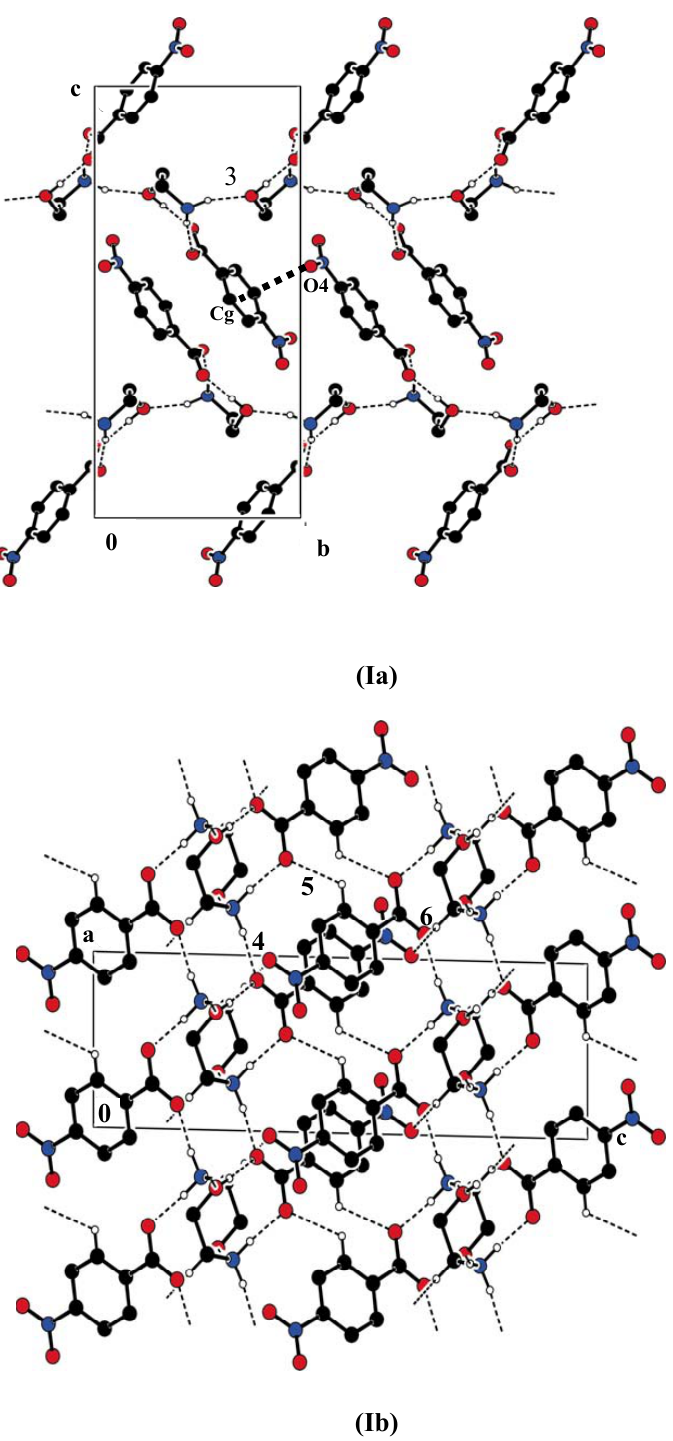
Fig. 2 ( Ia ) The helix-like chains along b direction in I formed by N2 ... O5 (3) hydrogen bonds (dashed lines). View of N1-O4 ... Cg ( π - ring) interactions (bold dotted lines). ( Ib ) The crystal packing of I showing the 2 − D layers where chains are joined by N2. . . O2 hydrogen bonds (4). The layers are further interlinked by C2. . . O1 (5) and C8. . . O3 (6) hydrogen bonds. Non-functional hydrogen atoms are omitted for